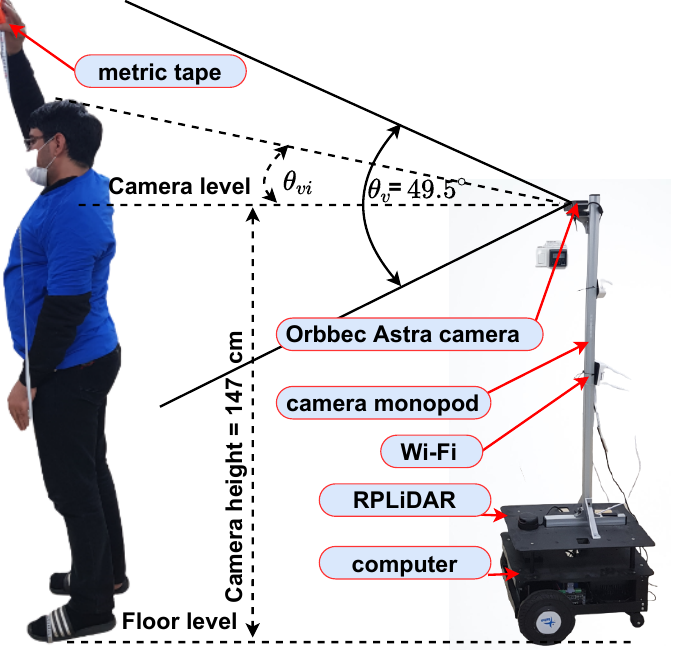
Figure 3. Mobile robot mounted with an RGB-D camera and necessary